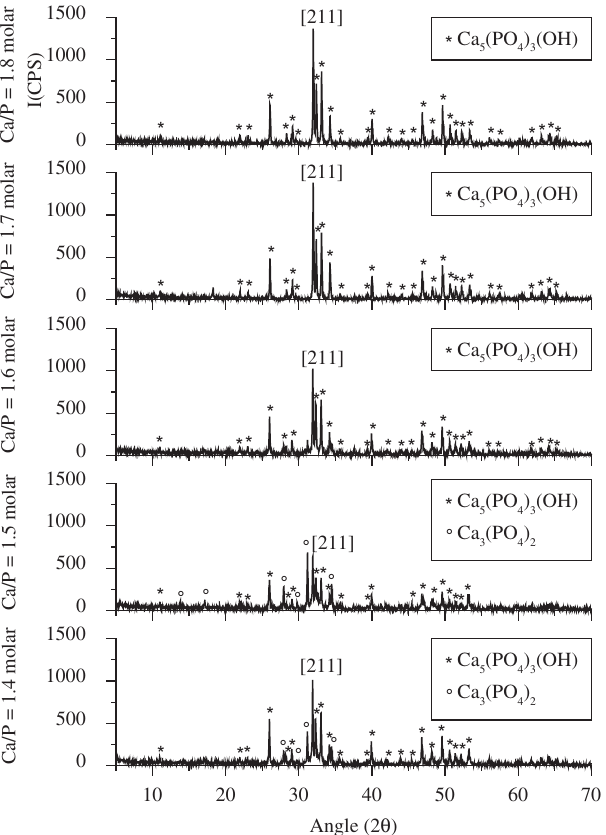
Figure 10. Spectra of X ray diffractometry on specimens, which had been hydrated for 28 days for the different compositions (peaks per second as a function of 2 θ